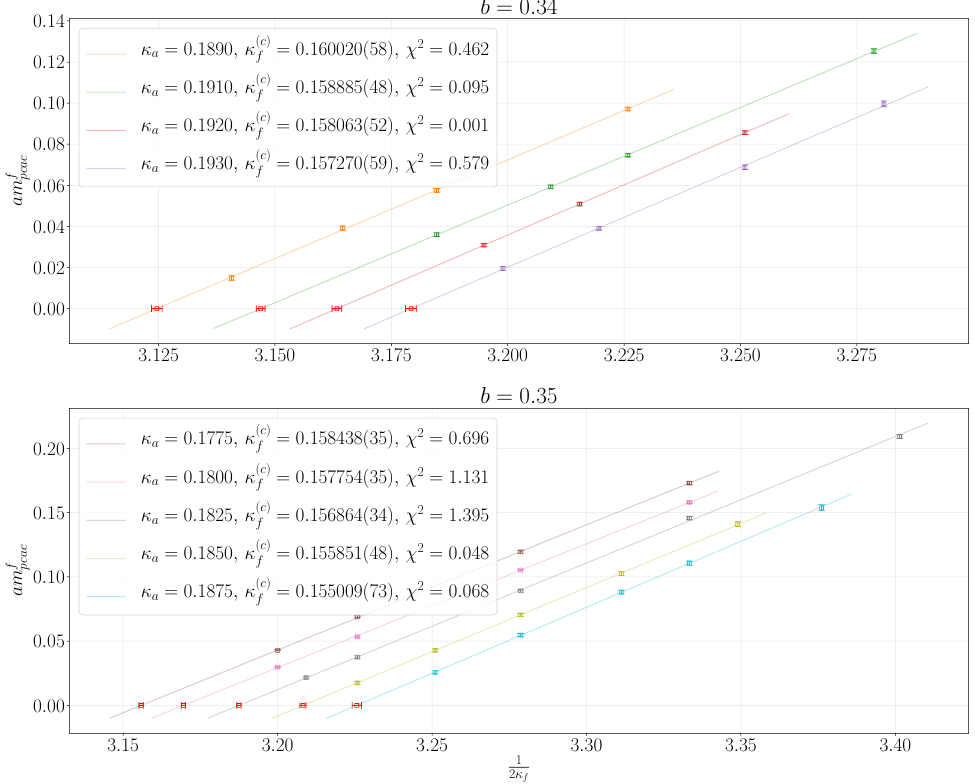
Figure 9. Extrapolation of am f to 0. In the labels we report the corresponding value of κ ( c ) pcac extracted from the fit and the corresponding χ 2 per degrees of freedom. Errors are calculated using standard jackknife